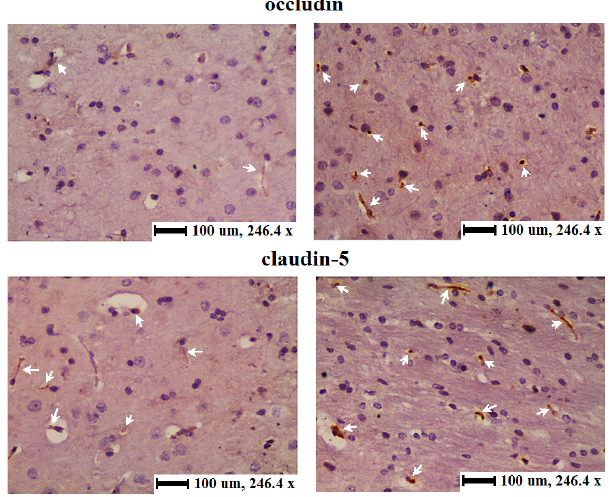
Fig. 6. The immunohistochemistry study of expression of occludin and claudin-5 (brown color) in cerebral vessels (arrowed) in adult (on the left) and newborn (on the right) rats.